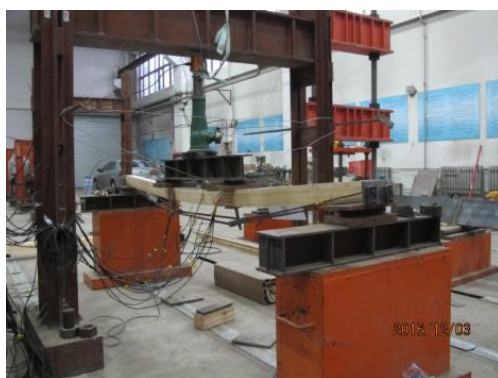
Figure 12. Photo of test.